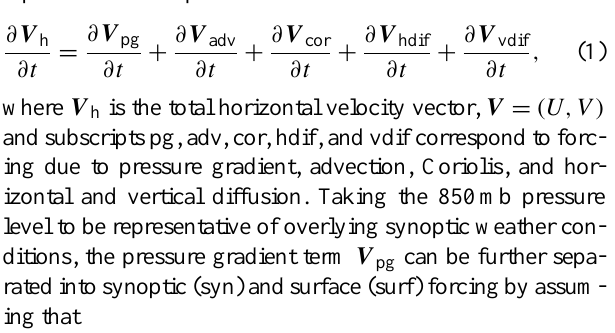
likely be explained by steep topography in close